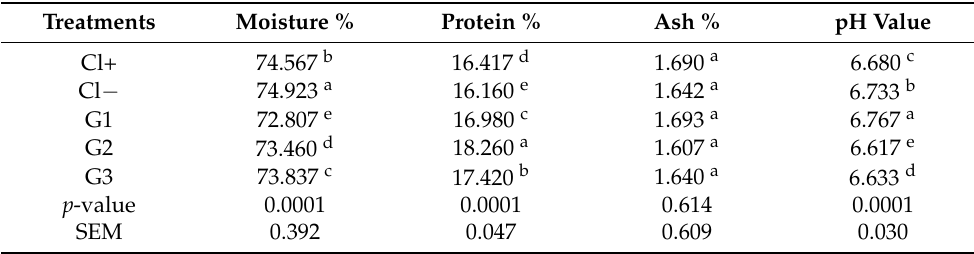
p -value The groups (G1–G3 and Cl+) received yogurts at a dose of 5 g/kg body weight/day. Means within a column with different letters are significantly different ( p < 0.05).